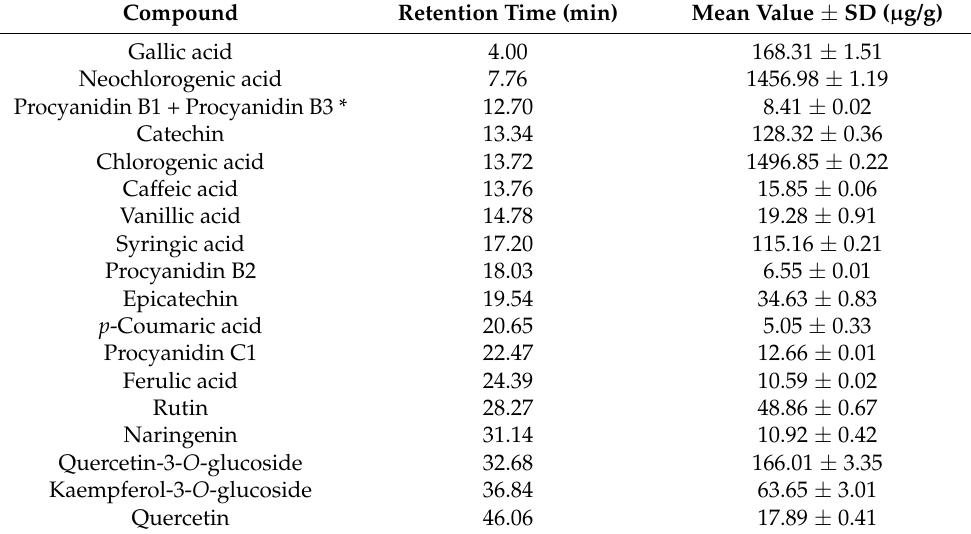
Table 2. Quantitative analysis of Thinned Nectarines polyphenols determined by HPLC-DAD- FLD analysis.